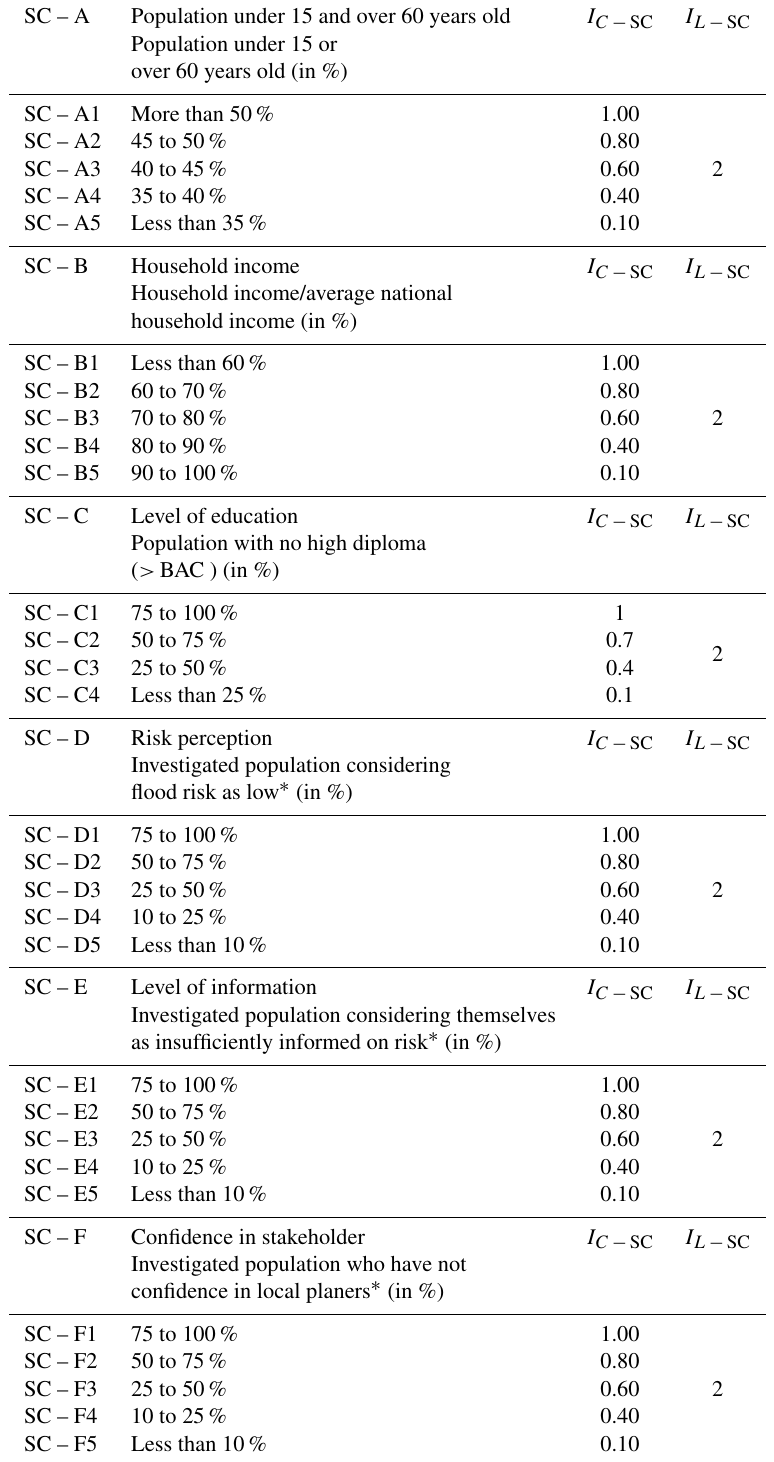
Table 5. Details of weights assigned to the criteria used in SCI calculation. Criteria with an ∗ are those derived from the risk-perception